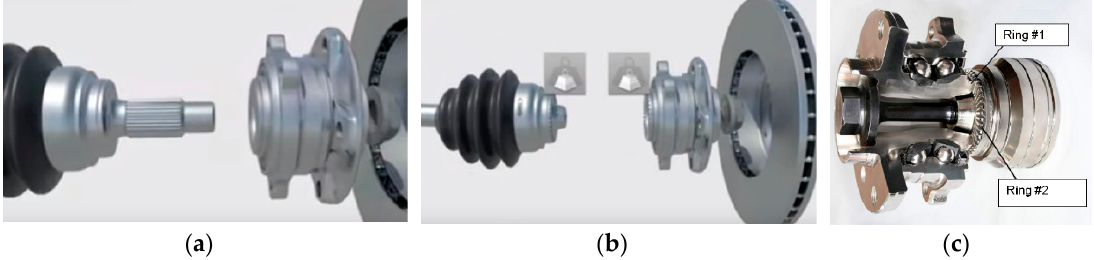
Figure 2. Example of Hirth connection in automotive: ( a ) old design with radial teeth and ( b , c ) new design with frontal teeth.